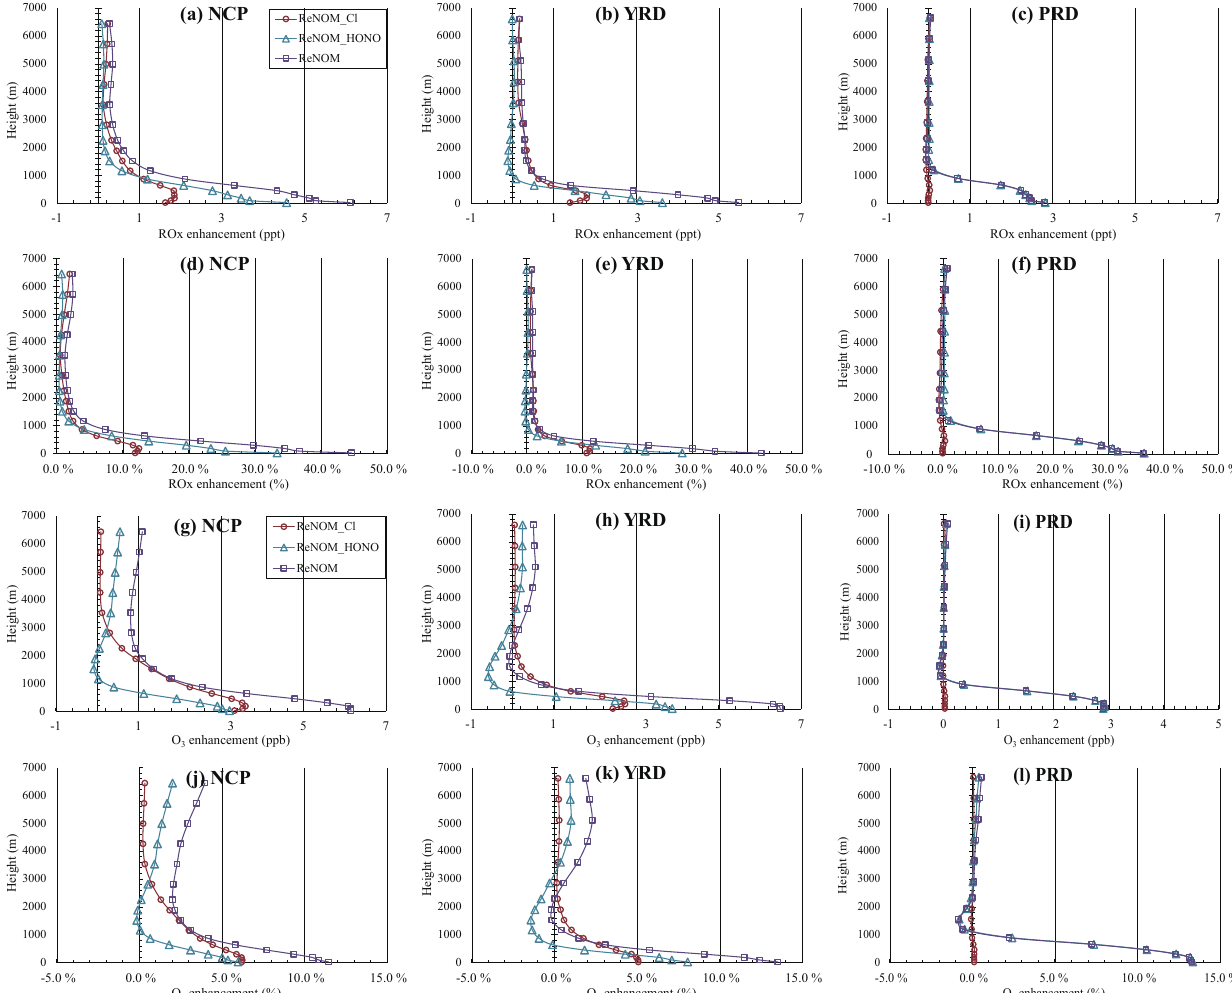
Figure 6. Daytime (06:00–18:00LT) vertical RO x enhancements (ppt) over the (a) NCP, (b) YRD, and (c) PRD regions; RO x percentage enhancements (%) over the (d) NCP, (e) YRD, and (f) PRD regions; O 3 enhancements (ppb) over the (g) NCP, (h) YRD, and (i) PRD regions; O 3 percentage enhancements (%) over the (j) NCP, (k) YRD, and (l) PRD regions.